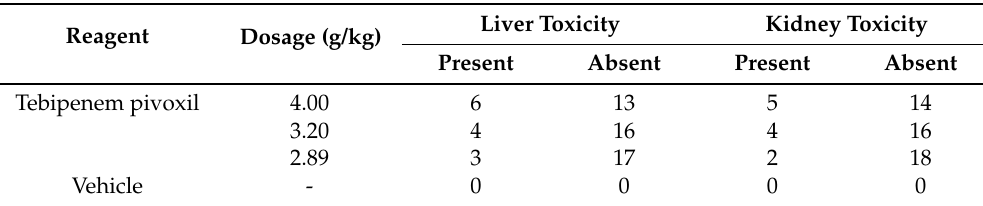
Table 4. Body weight of mice in groups administrations within 14 days (g) ( x ˘ s, n = 20). Group Dosage (g/kg) Vehicle -